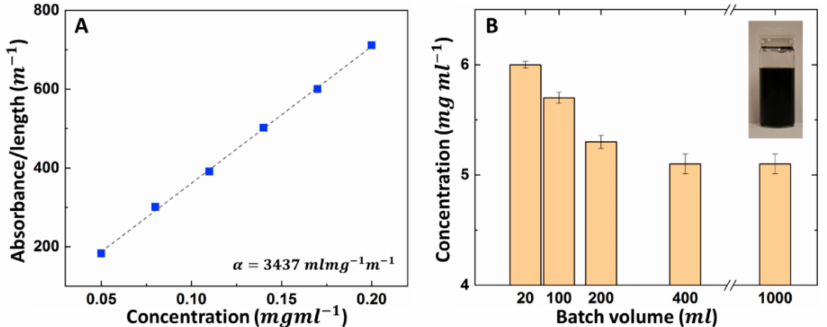
Figure 3. Graphene concentration measured given by ultraviolet (UV) absorption. ( A ) Absorption coe ffi cient obtained from ultraviolet-visible (UV-vis) spectroscopy at λ = 660 nm. ( B ) Change of graphene concentration with respect to batch sizes varying from 20 mL to 1000 mL. The resultant concentration of wet ball-milled graphene remains constant (5.1 mg mL) for batches larger than 400